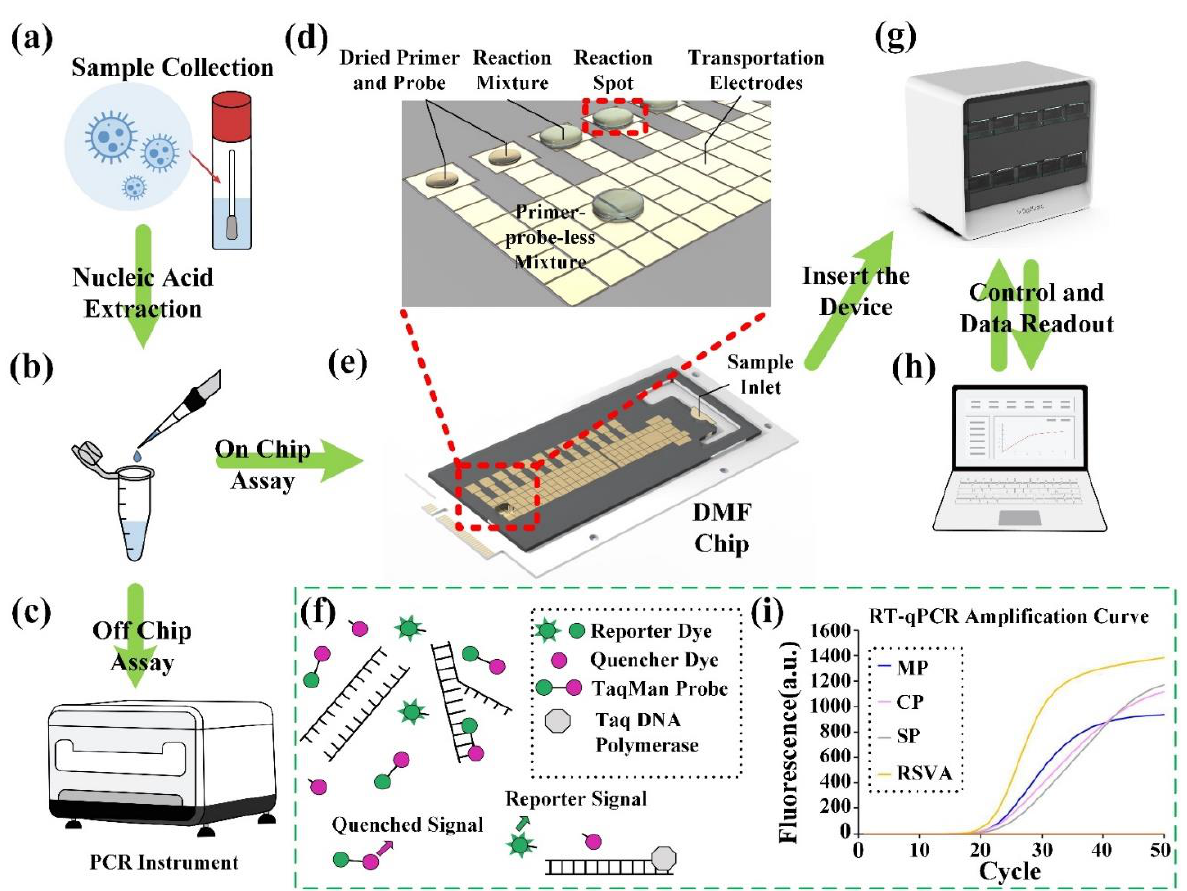
Figure 1. Schematic illustration of the processes of the DMF system for detecting multiple respiratory pathogens using the RT-qPCR method. ( a ) Clinical sample collection. ( b ) Off-chip nucleic acid extraction. ( c ) 3D schematic representation of the PCR thermocycling instrument. ( d ) Detailed illustration of the DMF chip with dried and rehydrated primer probes. ( e ) 3D schematic illustration of the DMF chip. ( f ) Schematic representation of RT-qPCR process. ( g ) The photograph of the DMF nucleic acid detector that is used to drive the DMF chip. ( h ) A custom software on a computer for controlling the device and collecting data. ( i ) Amplification curve obtained from RT-qPCR